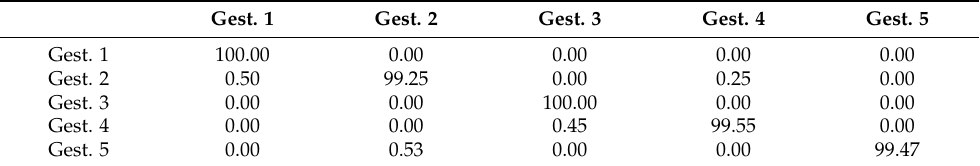
Table 4. The confusion matrix on the correctly detected foreground gestures for the proposed = 750 and r = 0.3. The cell located at row i and column j of the matrix represents algorithm with M TR the percentage in which Gesture i is classified as Gesture j . Gest. 1